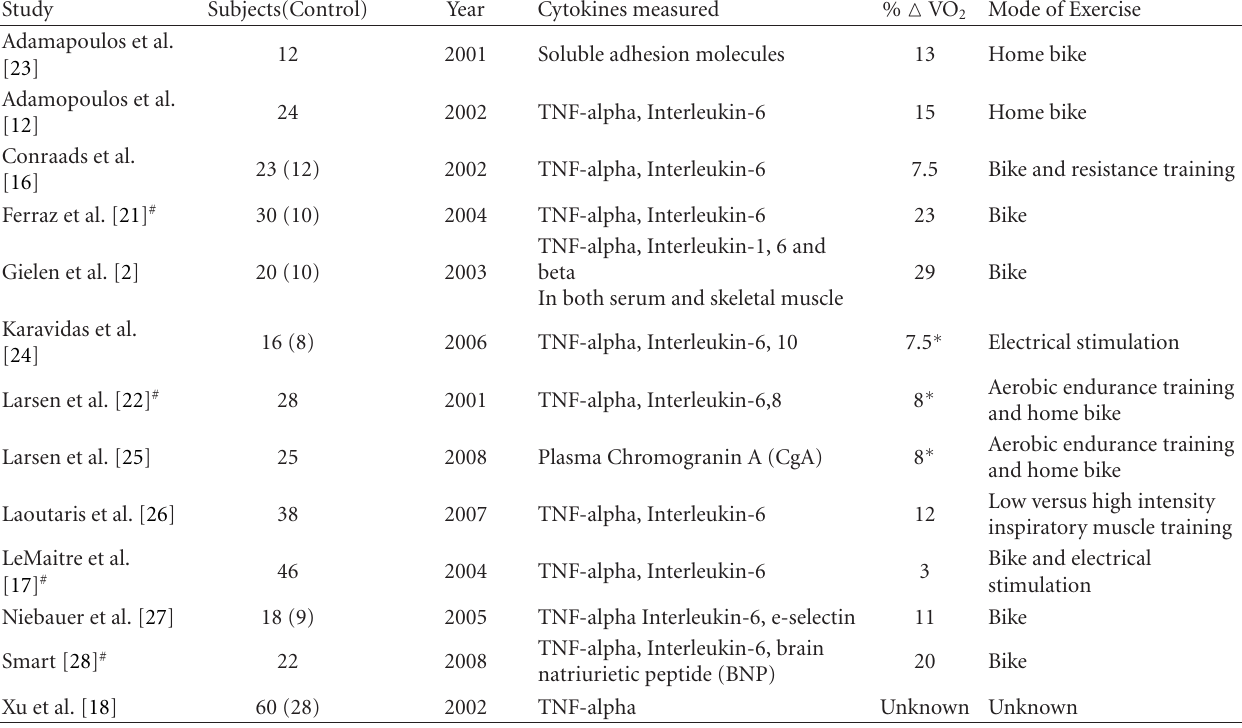
Table 1: Studies identified in PUBMED, MEDLINE